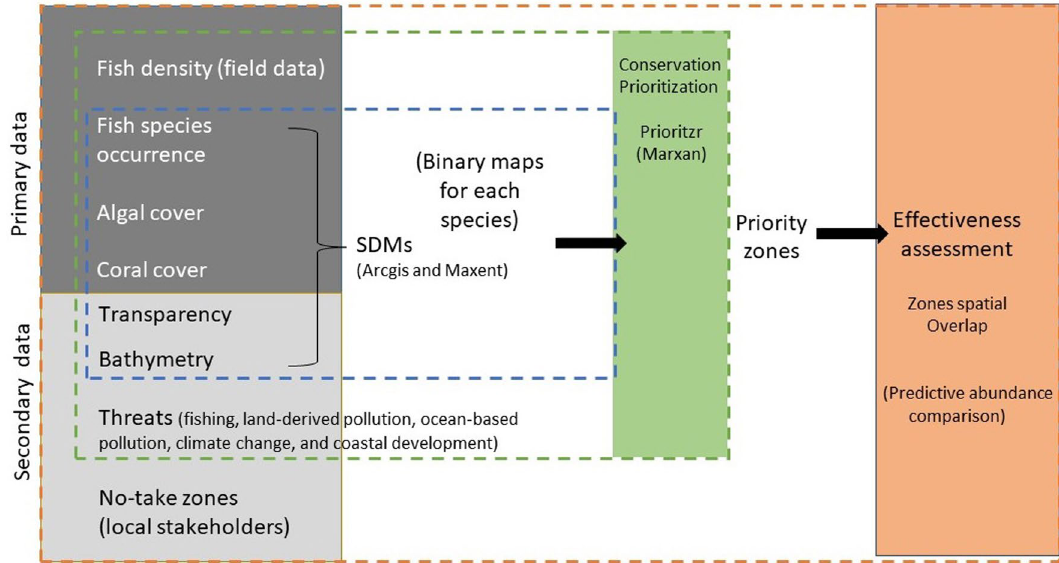
Figure 7. Flowchart of the methodological steps and types of data involved in the analysis of assessing the effectiveness of systematic and non-systematic